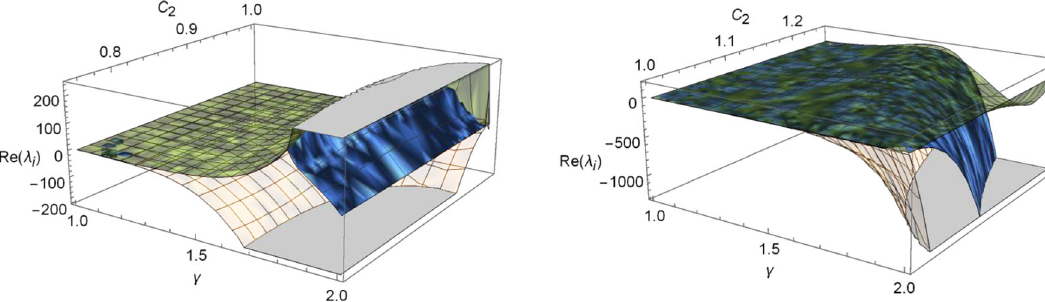
Fig. 7 Real parts of λ i corresponding to the equilibrium point P 8 for C 2 ≥ 2 + γ